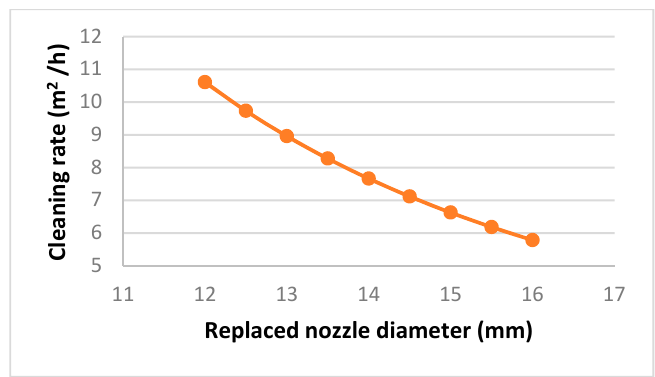
Figure 3. Cleaning rate versus replaced nozzle diameter.